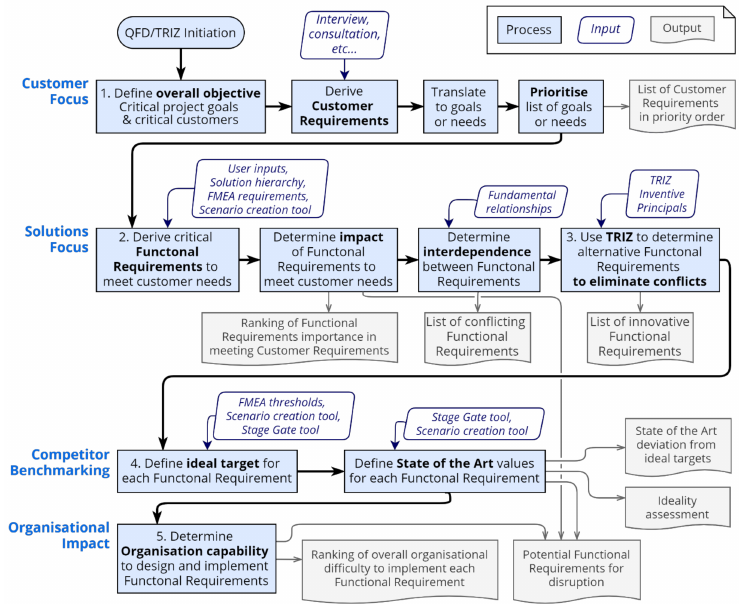
Figure 1. Flowchart to describe approach developed. Numbered steps refer to the subsections in Section